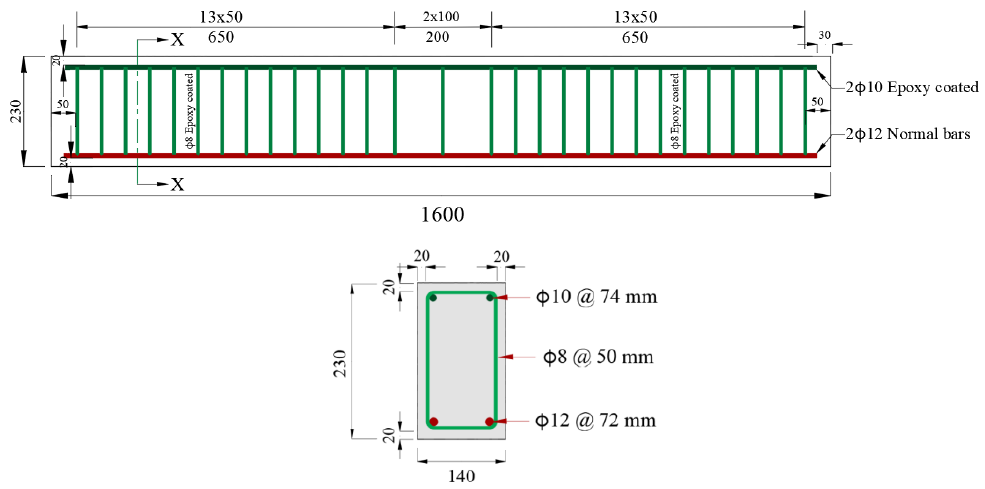
Figure 3 . Dimensions and reinforcement details of RC beam specimens (unit: mm). Figure 3. Dimensions and reinforcement details of RC beam specimens (unit: